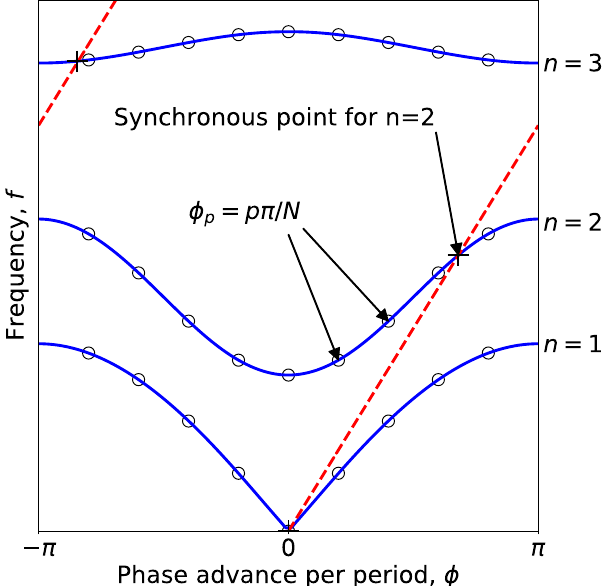
FIG. 2. An example of the dispersion diagram of a periodic structure with N periods. The blue lines represent the first three bands propagating in the structure, and the red lines represent the synchronous condition with the